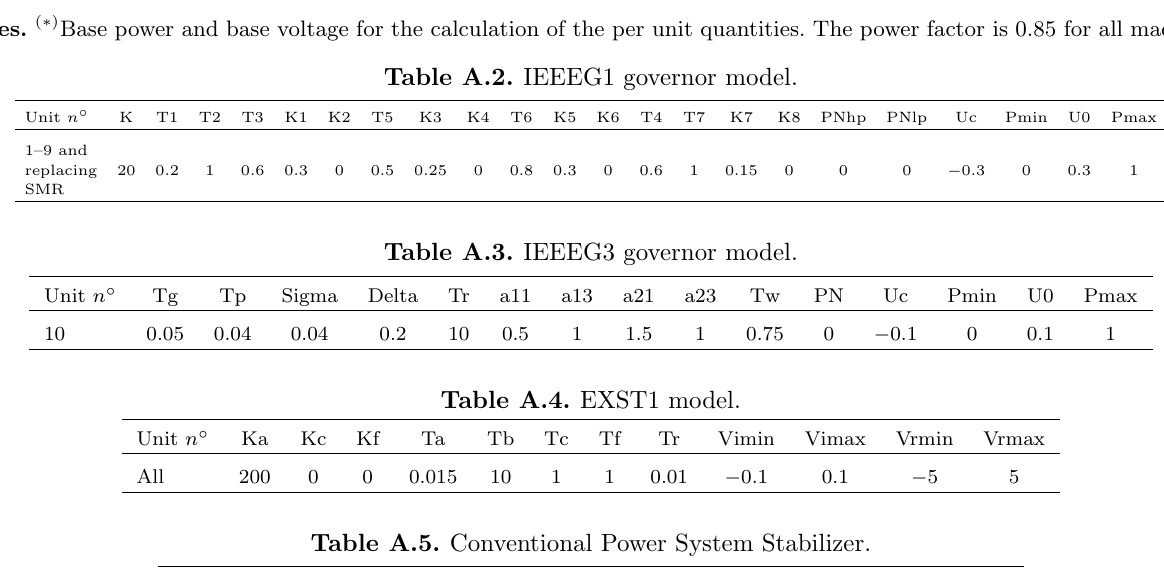
Table A.1 contains the features of the 10 machines of 39- bus grid and the features of the replacing SMR. Tables A.2 and A.3 contain the features of the two governor model used. Table A.4 contains the AVR parameters. Table A.5 associated with Figure A.1 represents the features and the diagram of the used PSS.